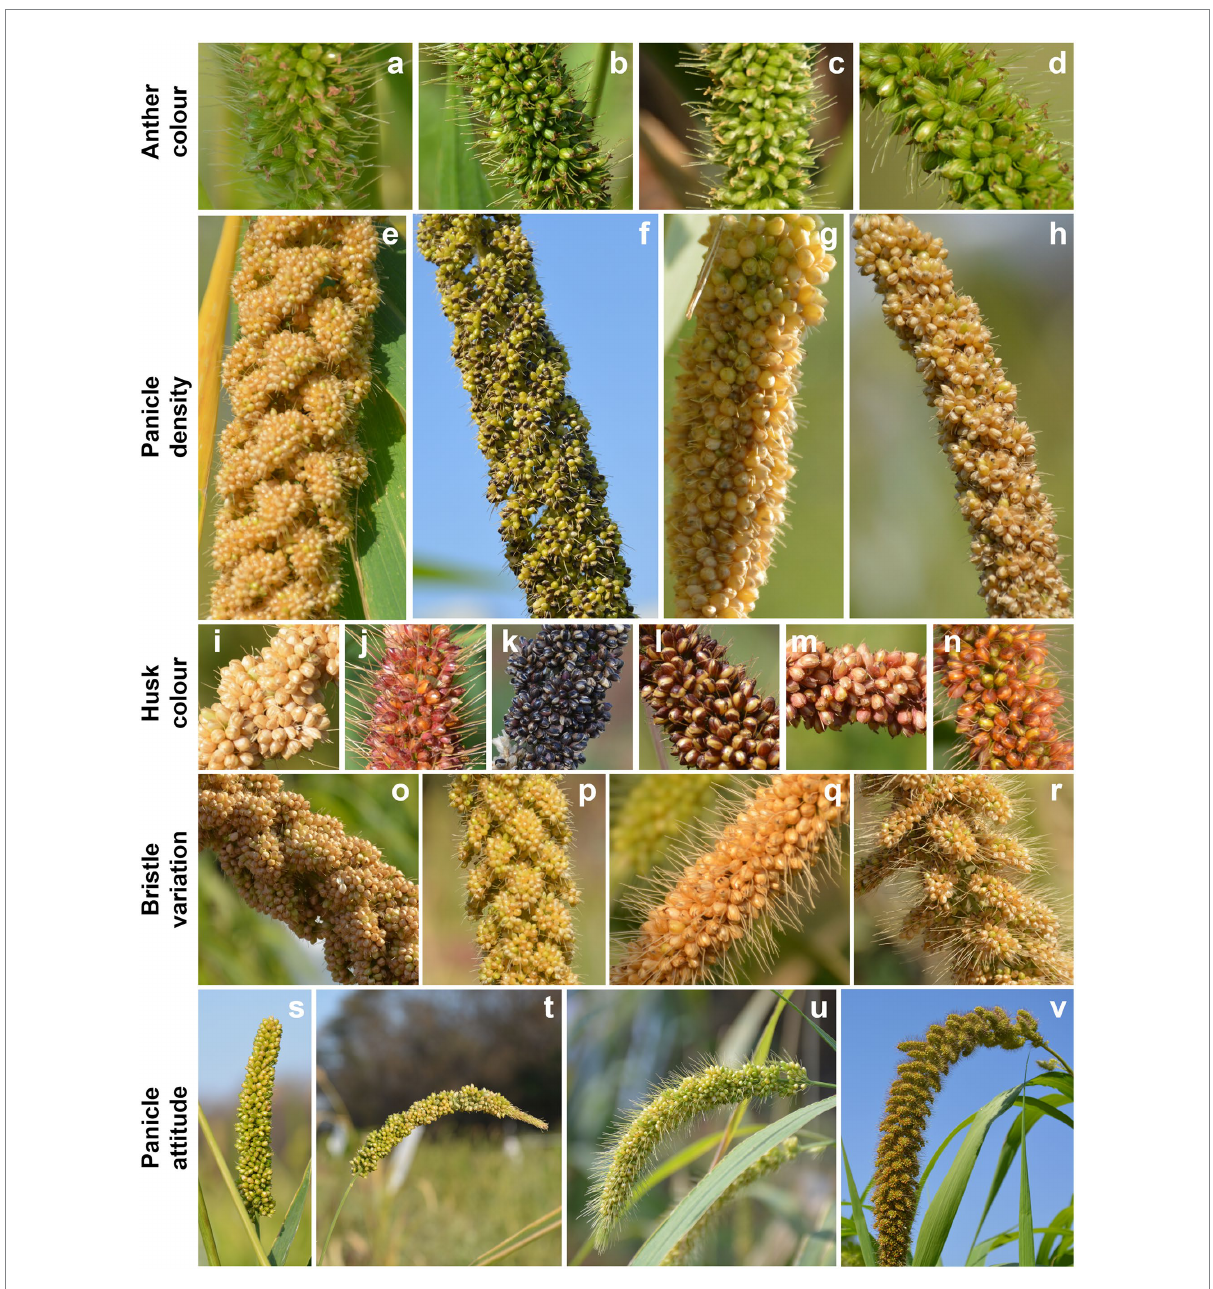
FIGURE 1 Genetic diversity of various seed-related traits in foxtail millet. Variation in anther color (A–D) , panicle density (E–H) , husk color (I–N) , bristles (O–R) , and panicle attitude (S–V) are shown. The names of the accessions are listed in Supplementary Table 1. figure not to